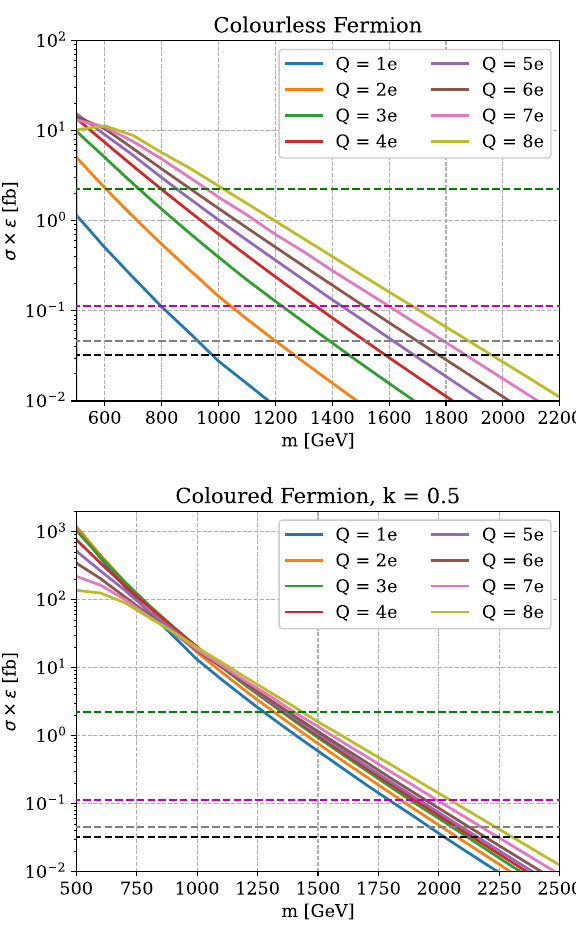
Fig. 7 Top left: open-production channel signatures for colourless scalars. Solid: effective cross sections σ · (cid:12) for CMS searches at √ s = 13TeV.Dashed:expectedupperbounds for L = 2 . 5(green),138